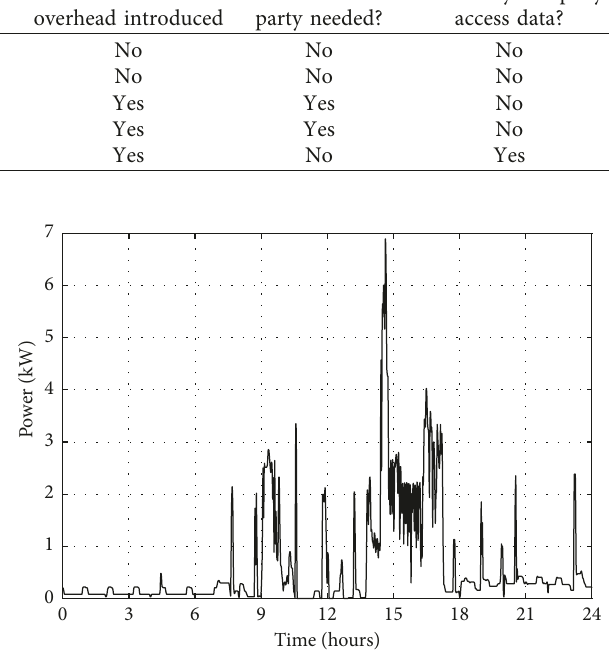
Figure 2: Approximation of typical household energy usage.